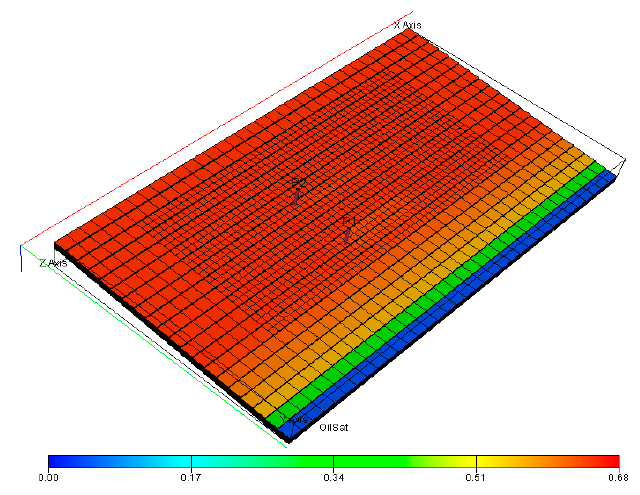
Figure 2. Initial oil saturation distribution in model I.